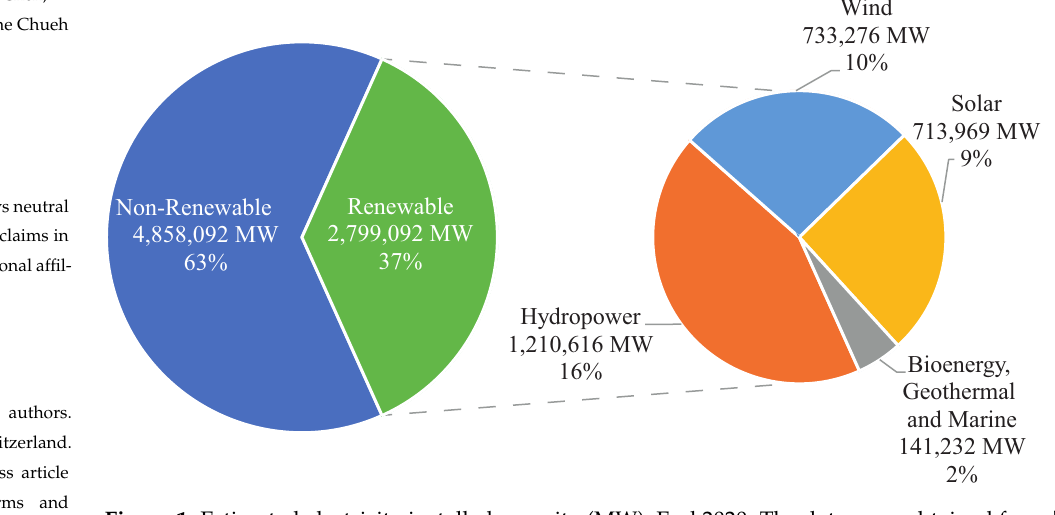
Figure 1. Estimated electricity installed capacity (MW). End 2020. The data were obtained from